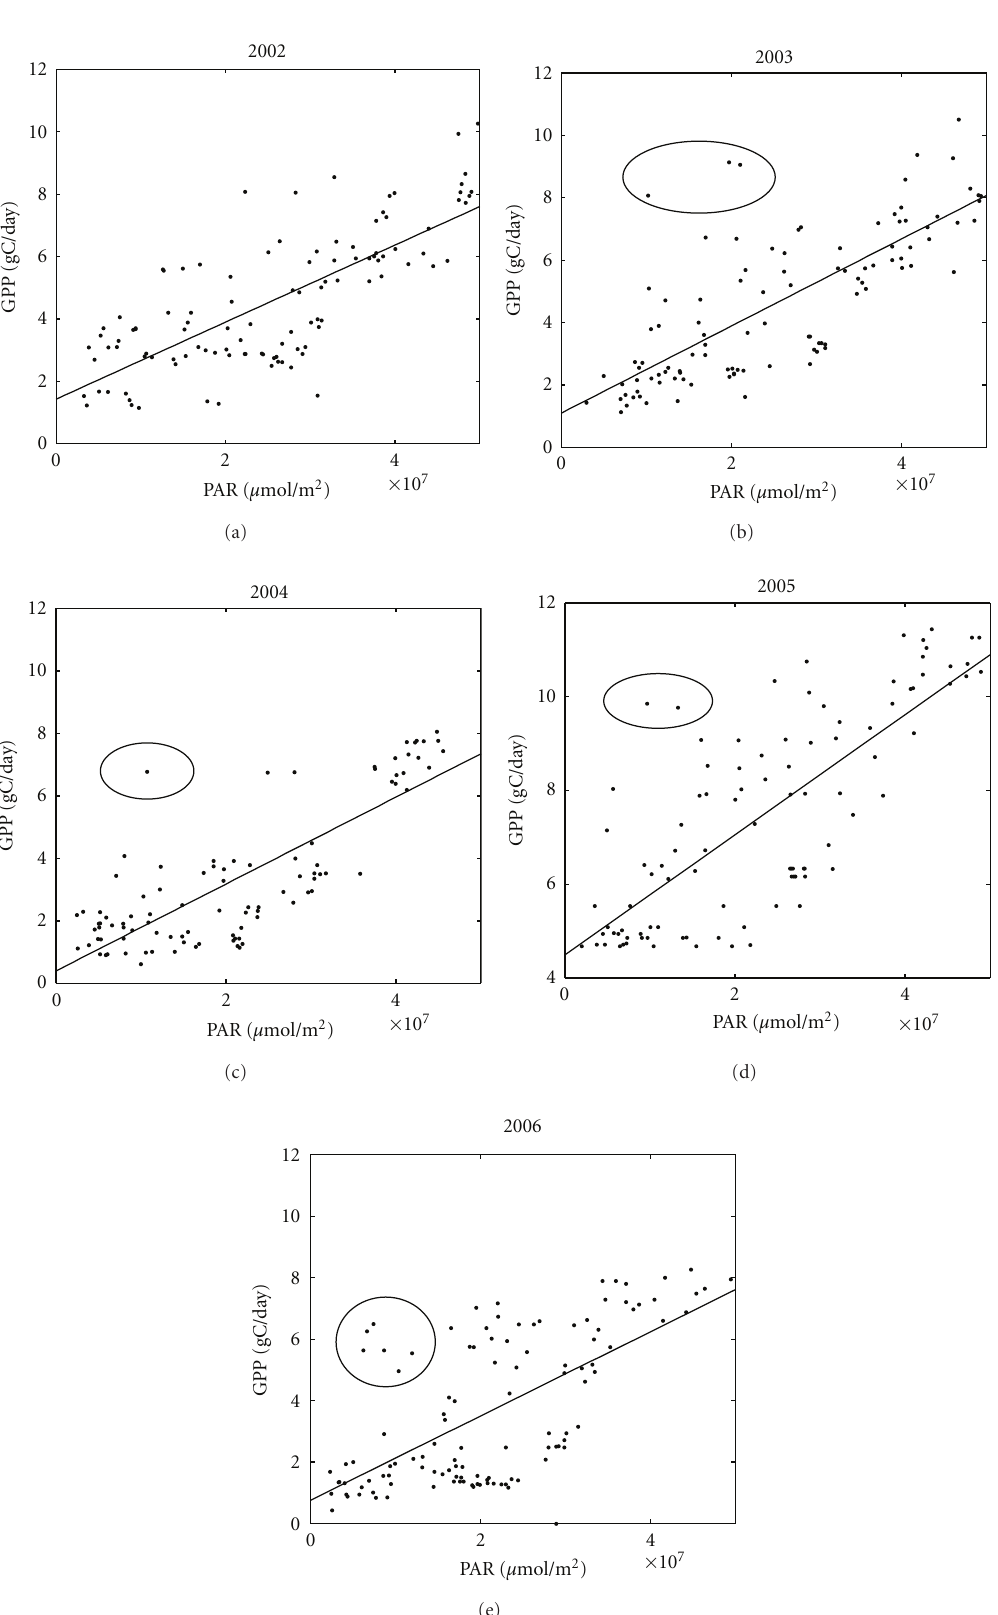
Figure 7: The relationship between daily PAR and GPP in the growing season of the open grassland before GPP declined. Pulses due to rain events are highlighted by